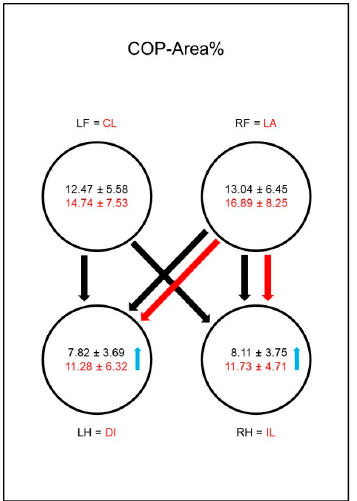
Figure 17. Area encompassed by the boundaries of the center of pressure movement as a percentage of paw contact area (COP-Area%) in study group 2 and control group. For detailed explanation and abbreviations refer to Figure 2.